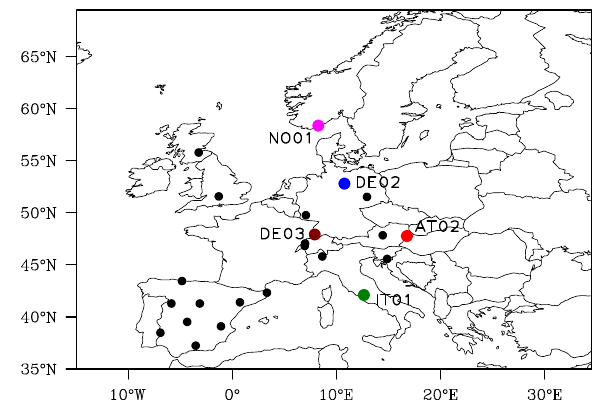
Fig. 1. Geographical domain of the simulation and EMEP stations used for the dynamic evaluation (Sect. 4). The stations with a colored dot provide data for PM2.5, sulfate, nitrate, and ammonium, while those with a black dot only provide PM2.5 data.